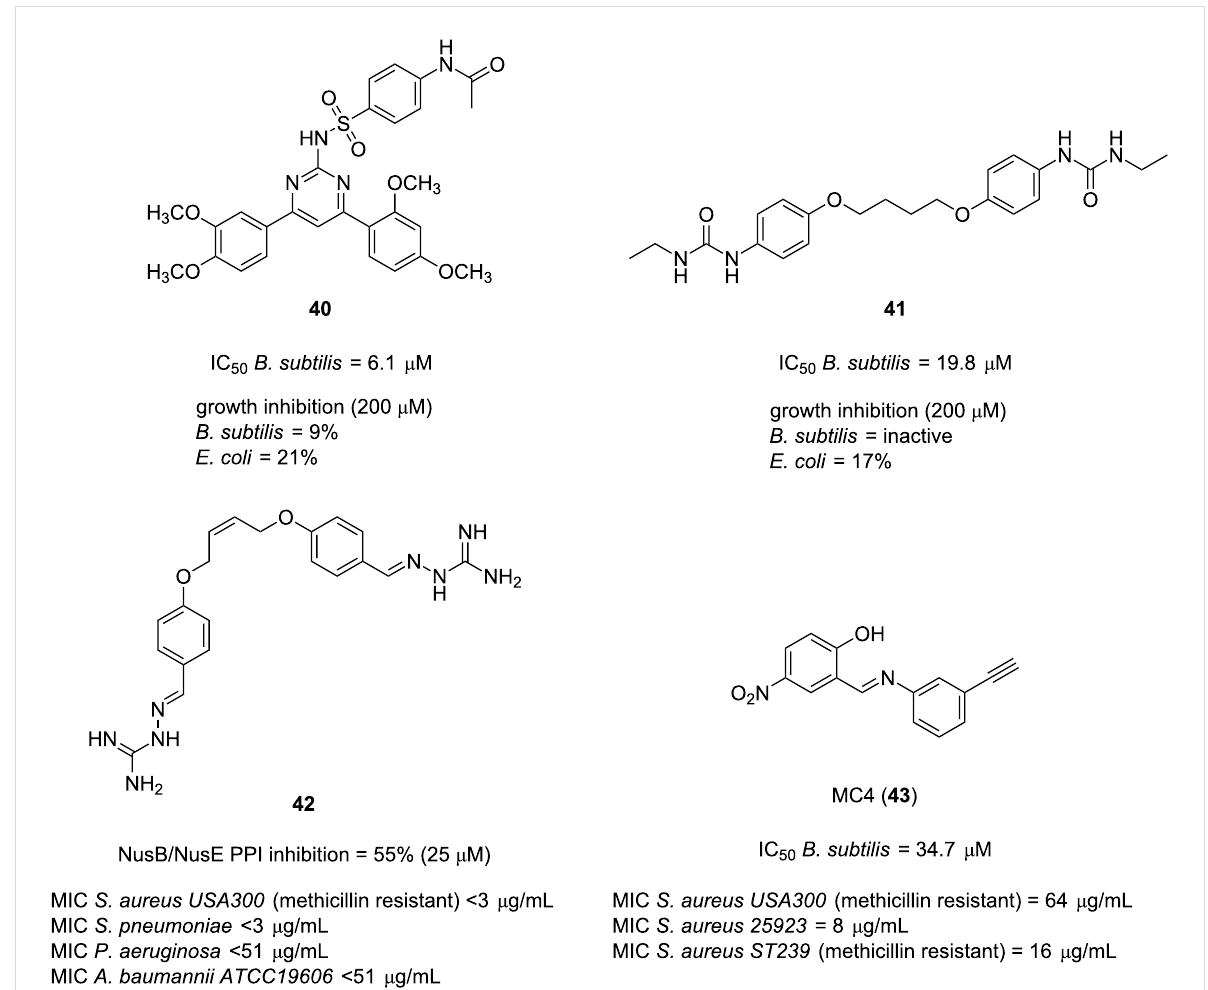
Figure 9: Inhibitors of the NusB/NusE interaction.